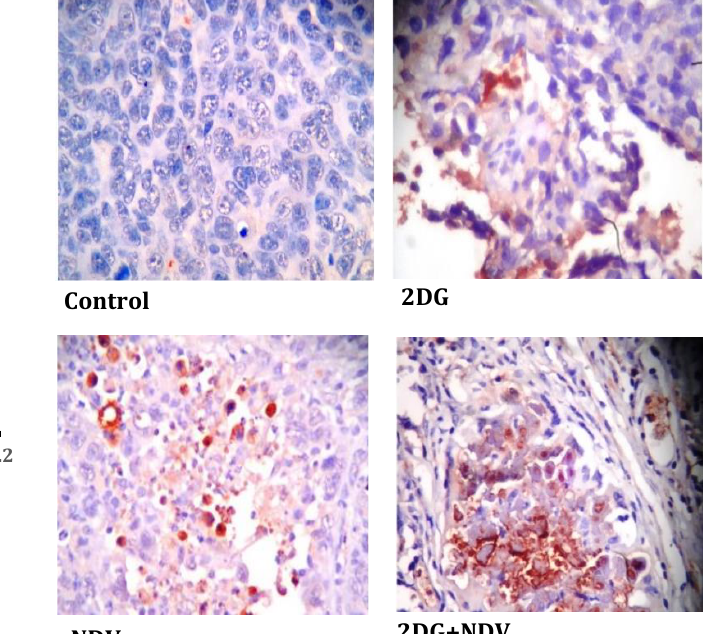
Figure 4 . Effect of 2DG and NDV on apoptosis of breast cancer in female